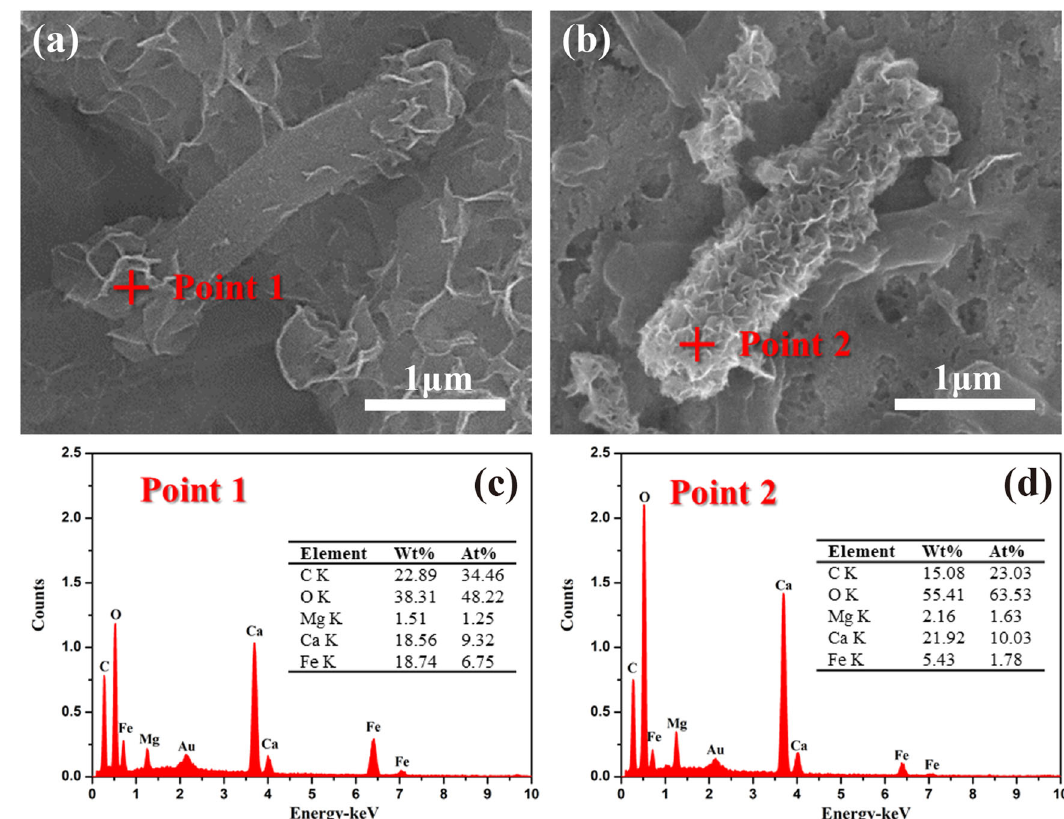
Fig. 4 SEM and EDS images of S. putrefaciens cells on the surface of a Q235 coupon. a Third day, b seventh day, c point 1, d point